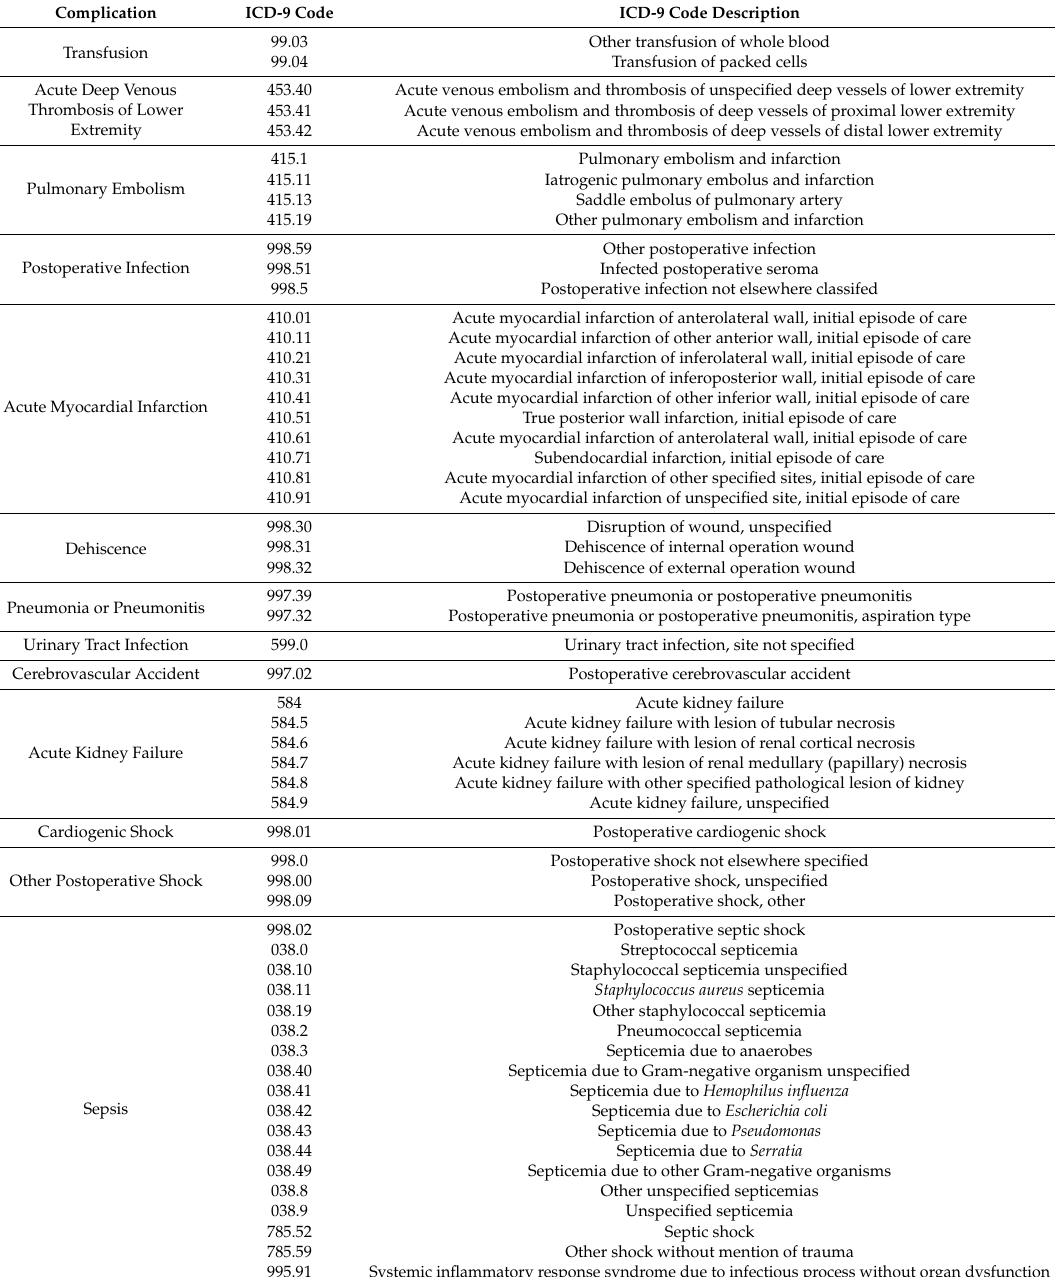
Table A1. ICD-9 Codes Used to Identify Postoperative